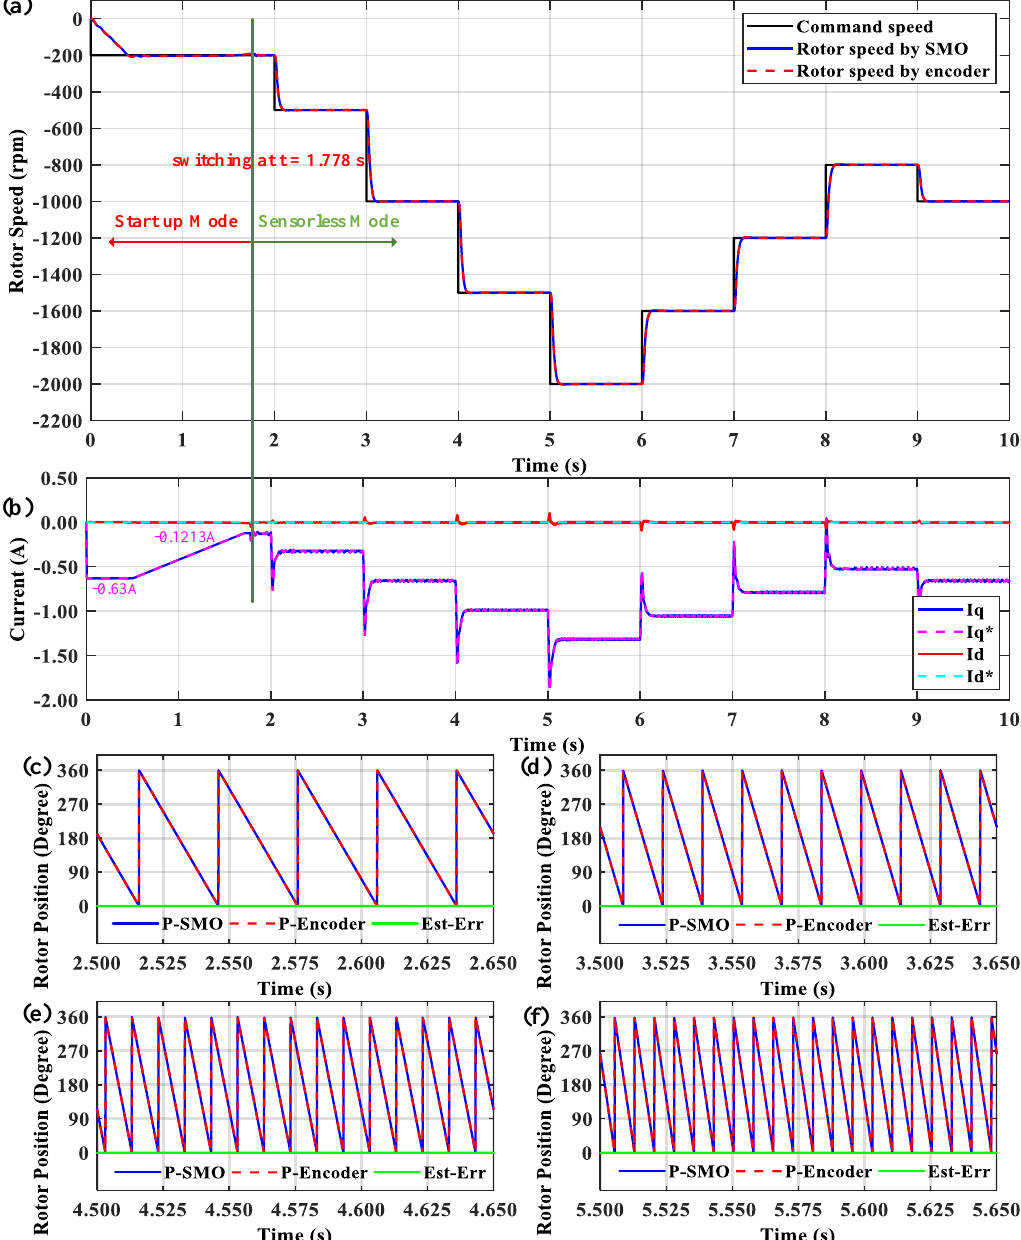
Figure 9. Simulation results in the wide speed range in the negative direction for: ( a ) speed response; ( b ) current response; and rotor position response at ( c ) 500; ( d ) 1000; ( e ) 1500; and ( f ) 2000 rpm.